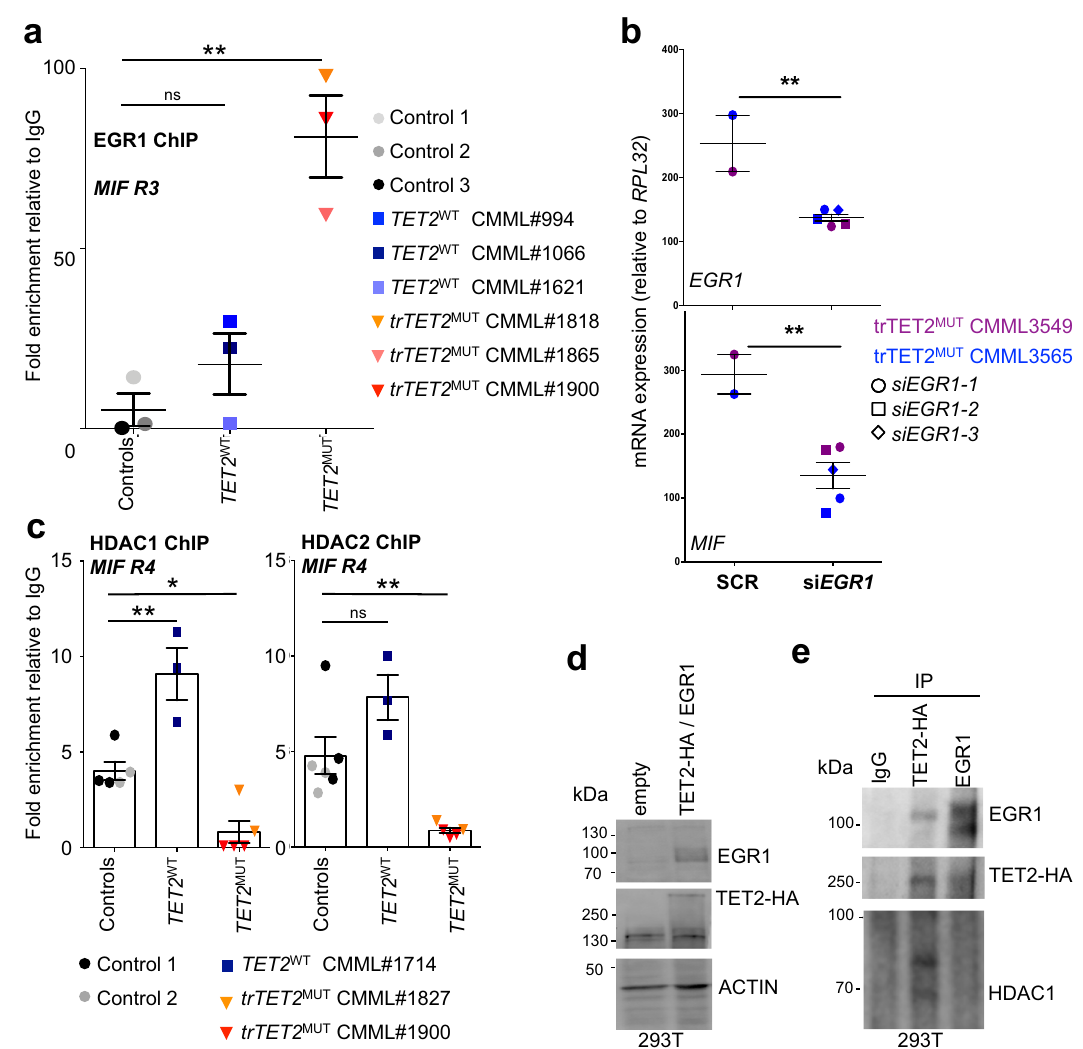
Fig. 5 EGR1 is recruited to the MIF promoter in tr TET2 -mutant CMML monocytes. a Quantitative ChIP-PCR analyses of MIF promoter (R3) were performed in sorted peripheral blood monocytes collected from three healthy donors (controls, circles) and 6 CMML patients, including 3 TET2 WT (squares) and 3 trTET2 MUT (triangles) cases. EGR1-associated DNA was immunoprecipitated. Results are expressed as fold enrichment relative to DNA immunoprecipitated with control immunoglobin G (IgG). Data are mean + / − SEM of each sample run in triplicate. Dunnett ’ s multiple comparison test using control monocytes as control, ns, non-signi fi cant, ** P < 0.01. b siRNA-mediated downregulation of EGR1 in trTET2 MUT monocytes isolated from CMML3549 (purple) and CMML3565 (blue) with 2 and 3 sets of EGR1 -siRNA respectively. RT-qPCR analysis of EGR1 and MIF mRNA expression normalized to RPL32 . Data are mean + / − SEM of each sample run in triplicate. Unpaired Students-t test using control monocytes transfected with SCR as control, ** P < 0.01. c Quantitative ChIP-PCR analyses of MIF promoter performed in 2 controls, one TET2 WT CMML and 2 trTET2 MUT CMML using antibodies against HDAC1 and HDAC2, focusing on R4 of MIF gene. Data are mean + / − SEM of each sample run in duplicate or triplicate. Dunnett ’ s multiple comparison test using control monocytes as control, ns non-signi fi cant, * P < 0.05, ** P < 0.01. d 293T cells were transfected using Lipofectamine 2000 with empty vectors or pcDNA3-EGR1 and pcDNA3-HA-TET2. Immunoblot analysis of EGR1 and HA expression in transfected 293T cell. Actin, loading control. e Co-immunoprecipitation experiments in 293T-transfected cells. An anti-HA (HA 16B12, Covance), an anti-EGR1 (303 – 390 A, Bethyl Laboratories) or a control IgG were used for IP, followed by immunoblotting with anti-EGR1, anti-HA, and HDAC1 (#39531, Active